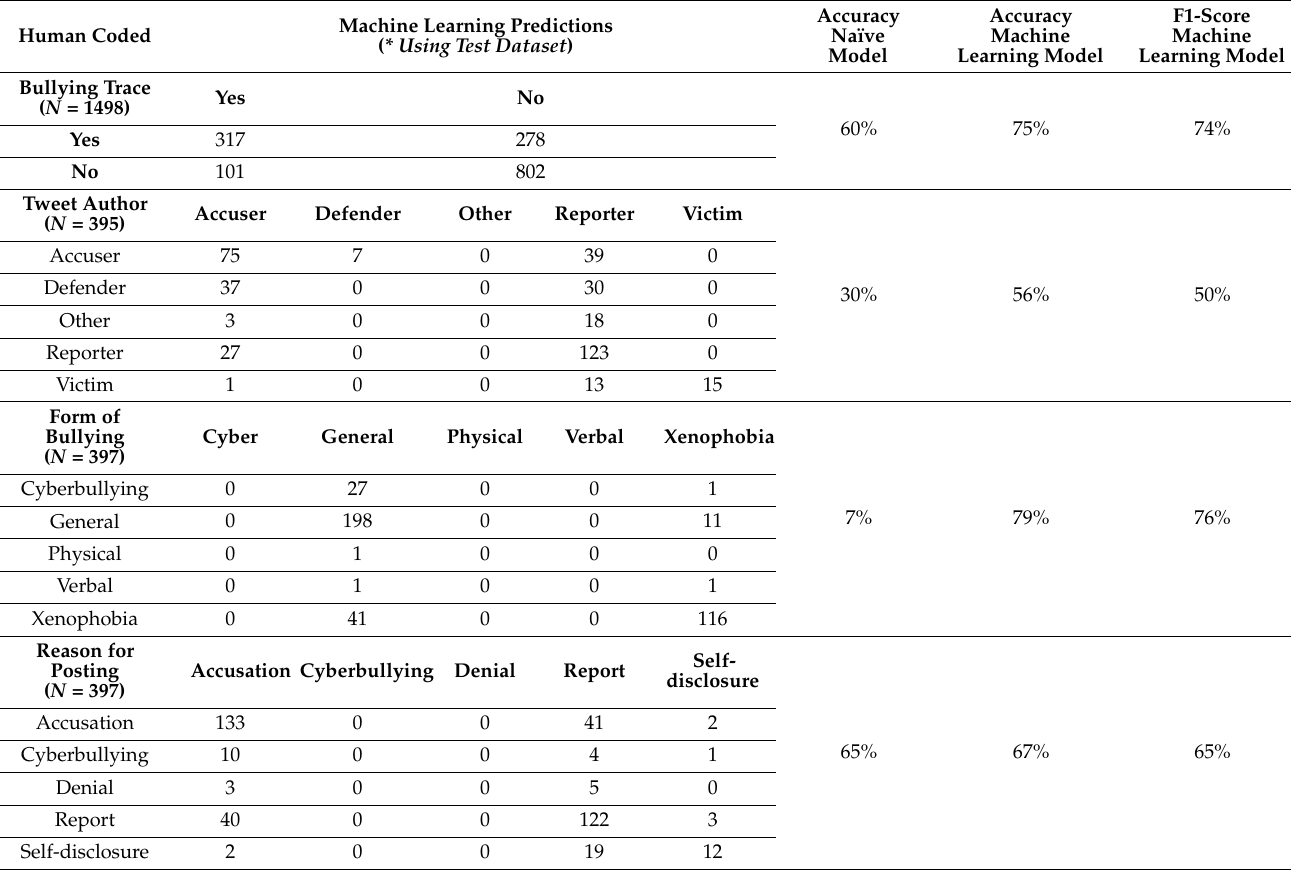
Table 1. Confusion matrix showing agreement and disagreement between human coding and machine learning